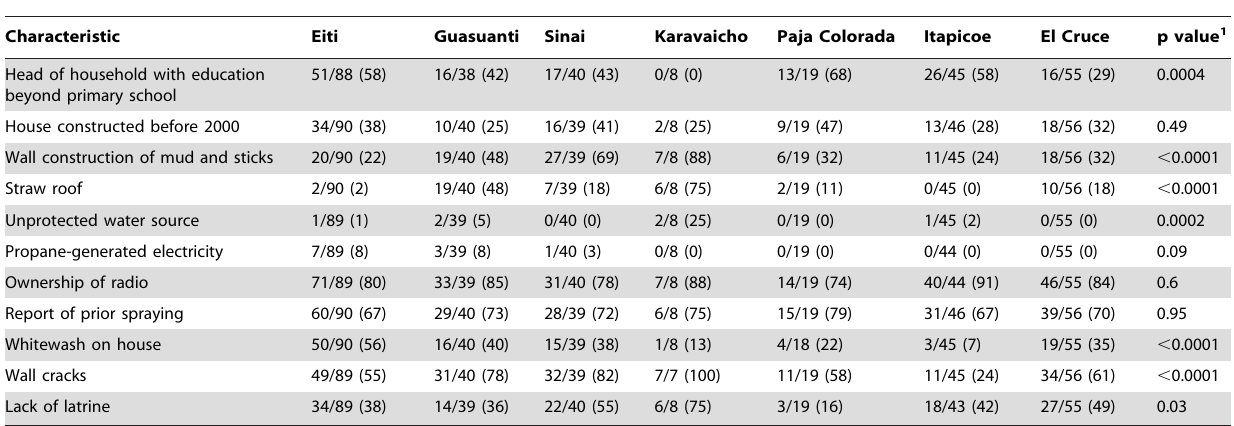
Table 2. Distribution of potential risk factors among children 2–15 years old by village of